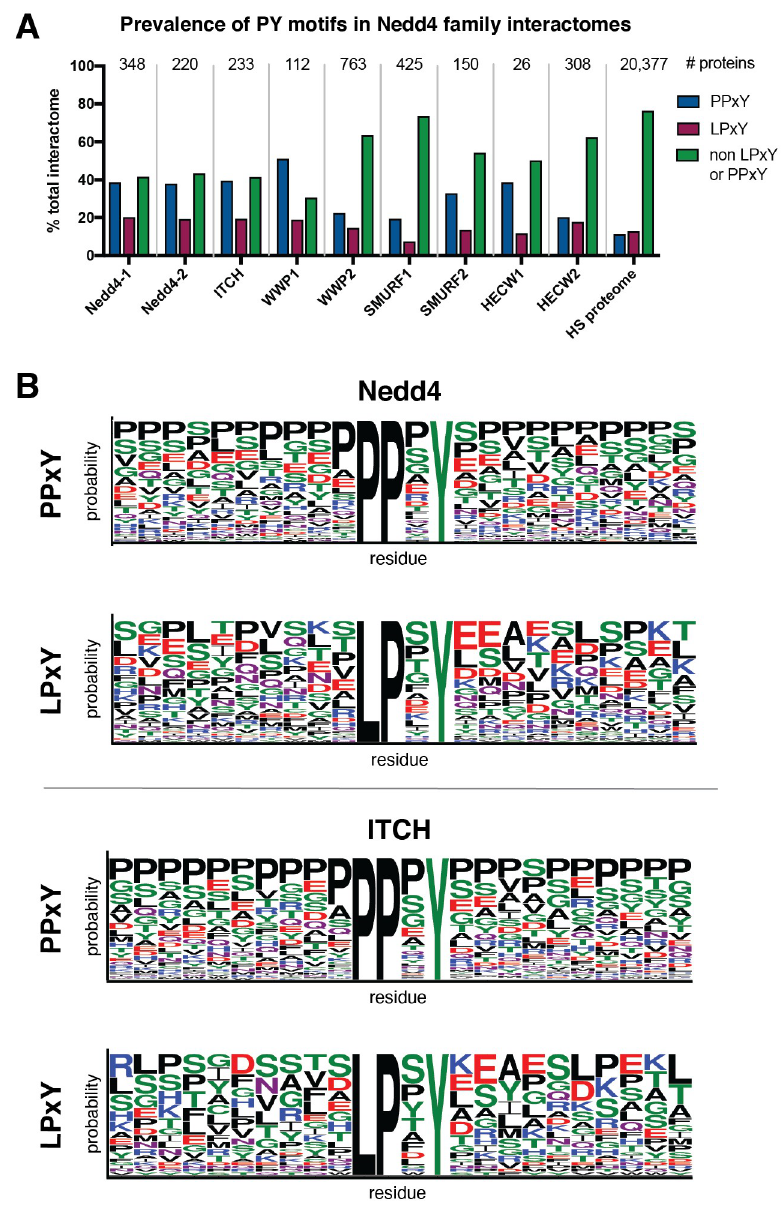
Fig 3. Analysis of PY motifs in interactomes of the Nedd4 family of ubiquitin ligases. (A) Prevalence of PPxY and LPxY motifs in the interactome (from BioGrid database) [48, 49] across the Nedd4 family of ubiquitin ligases. (B) Representative WebLogo depictions of PY motif consensus sequences from all PPxY and LPxY motifs ± 10 amino acids for Nedd4 and ITCH. The WebLogo [50] diagrams for the remainder of the Nedd4 family ligases are shown in S2 Fig.